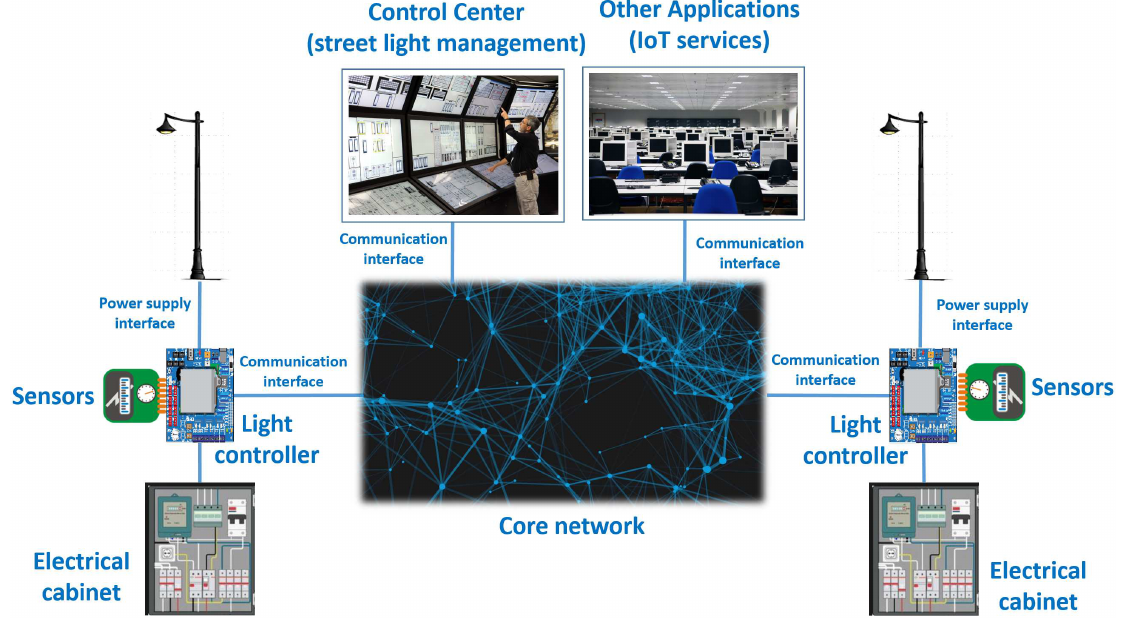
Figure 1. Architecture of a smart lighting